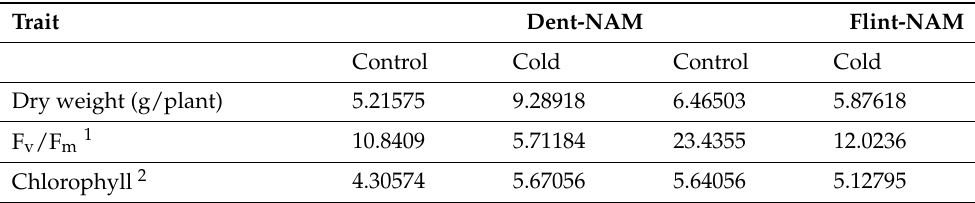
Table 1. Thresholds for − log10 p -values to declare a QTL as significant in the Dent and Flint-NAM sets under cold and control conditions. Trait Dry weight